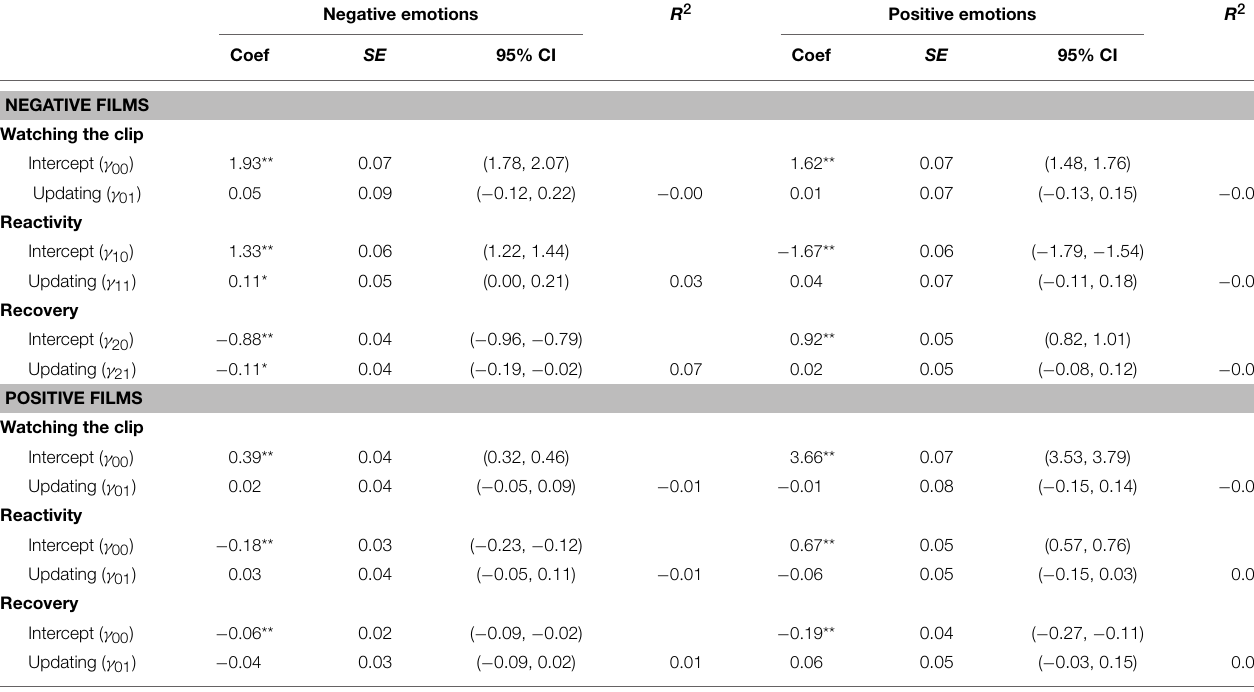
TABLE 2 | Moderating effect of updating on emotion reactivity to and emotion recovery from valenced film-clips in Study 1.